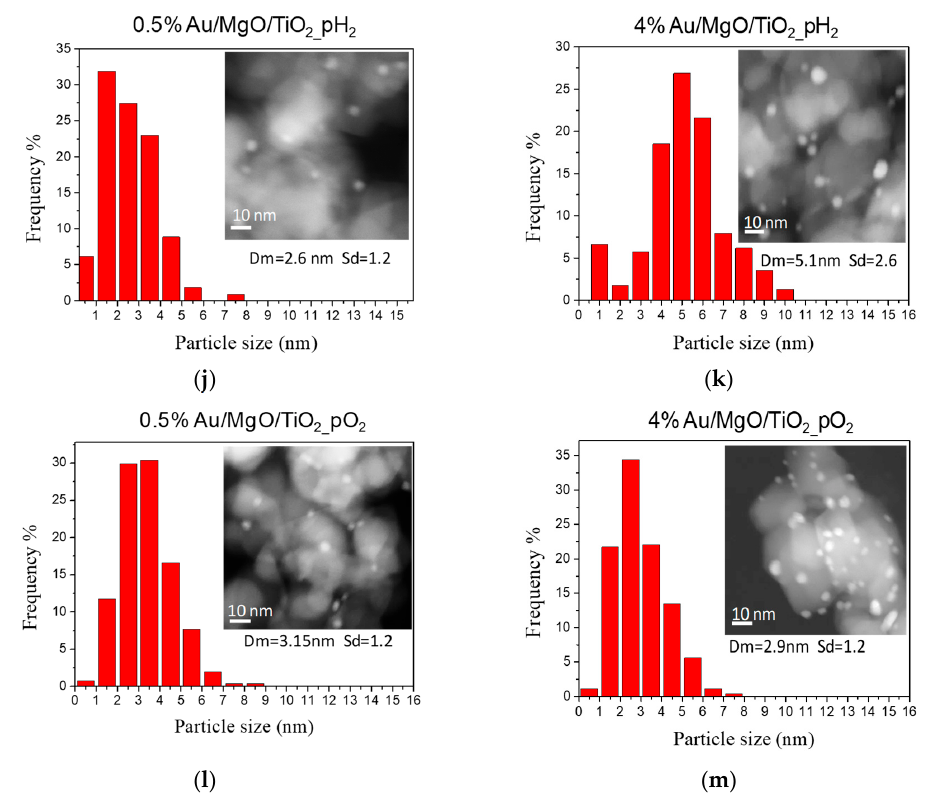
Figure 4. Au particle size distribution and representative STEM HAADF micrographs of catalysts Au/TiO 2 ( a – d ), Au/Fe 2 O 3 /TiO 2 ( e – h ), Au/MgO/TiO 2 ( j – m ), for different gold amounts (0.5 or 4 wt.%) and pretreatment atmospheres (H 2 or O 2 ).